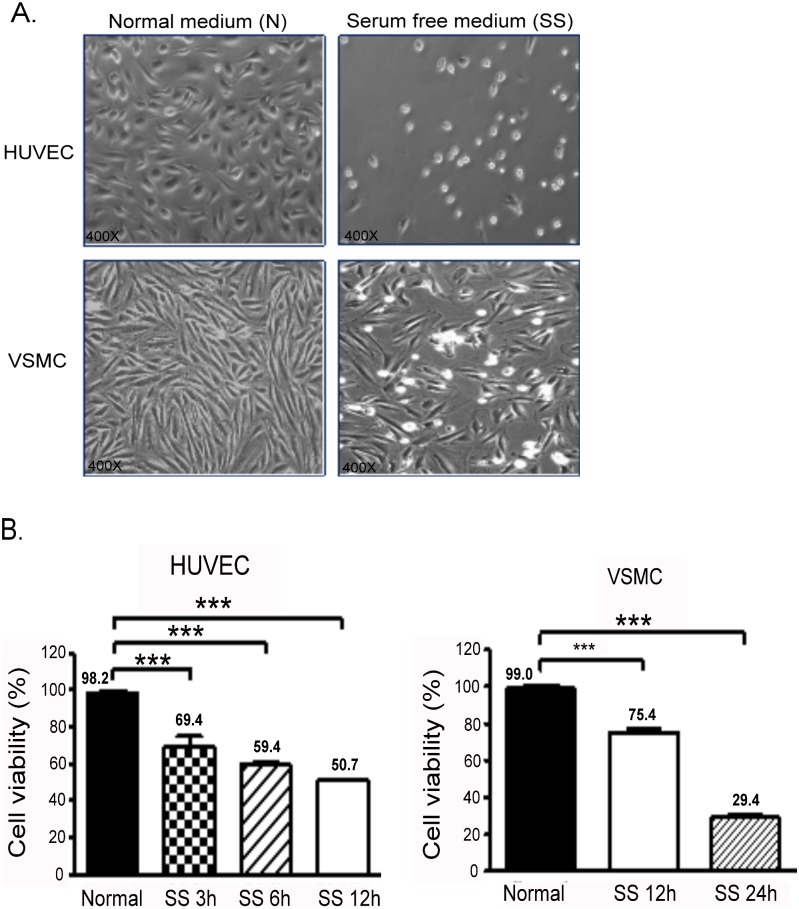
SS of HUVECs and VSMCs.(A) Effect of 24-h SS on cell morphology and density of HUVECs and VSMCs (right panel). (B) Cell viability was assessed after SS in HUVECs (at 3, 6, and 12 h) and in SMCs (at 6 and 12 h). The mean percentages of at least 3 independent experiments are represented in both cells. The square insert indicates the magnified area. ***P < 0.001 in comparison to cells without SS. Data are expressed as the mean ± SE and are representative of 3 experiments.